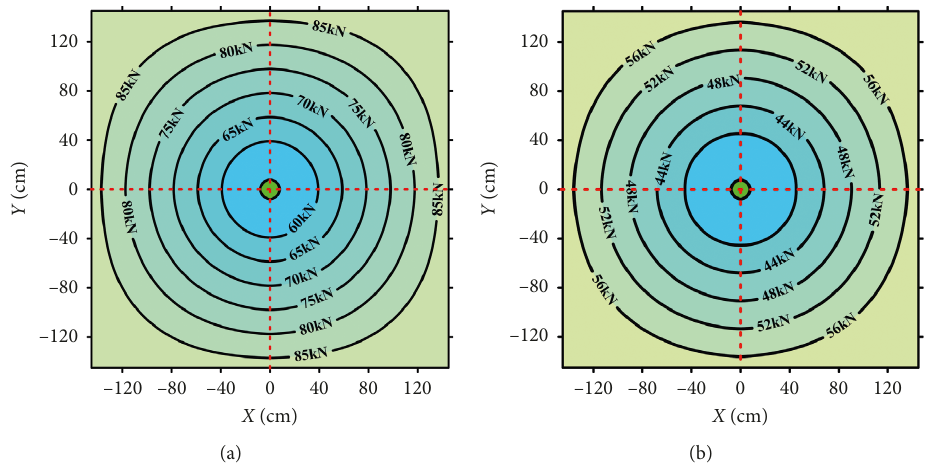
Figure 6: Range of ground uplift at various loads. (a) Test II and (b) Test